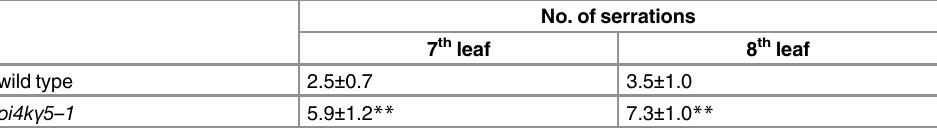
Table 1. Statistics of serration numbers of the 7 th and 8 th leaves of wild type and pi4k γ 5 – 1 plants. Data are presented as means ± SD (n = 30) and statistically analyzed by Student ’ s t test ( ** , P < 0.01, com- pared to those of wild